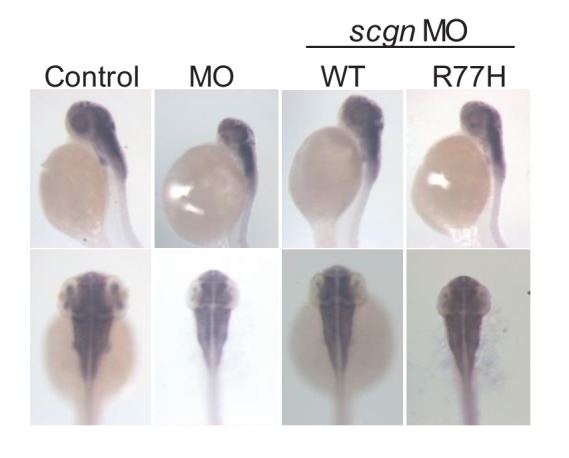
Bright-field images of zebrafish after morpholino injections (MO).In-situ hybridization of HuC (elavl3) was performed in embryos at 48 hr post fertilization to highlight the developing brain. Control: control MO injection; MO: scgn MO injection; MO+WT: SCGN MO and human SCGN WT mRNA co-injection; MO+R77H: SCGN MO and human SCGN R77H mRNA co-injection. All injections are performed at one-cell stage of the development.